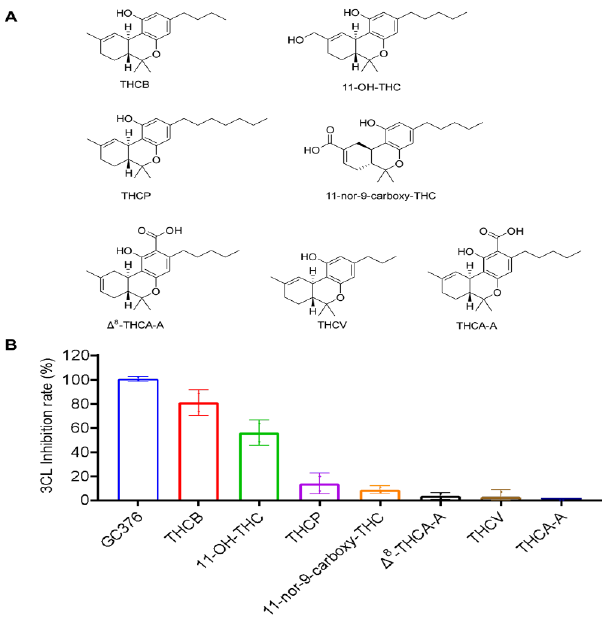
Figure 1. The chemical structures of the THC-type of cannabinoids ( A ) and their inhibitory effect on the activity of SARS-CoV-2 M pro ( B ). These cannabinoids were tested at a concentration of 10 μM with the MBP-tagged SARS-CoV-2 M pro inhibition assay. GC376 was used as the positive control and each test compound was assayed in triplicate.